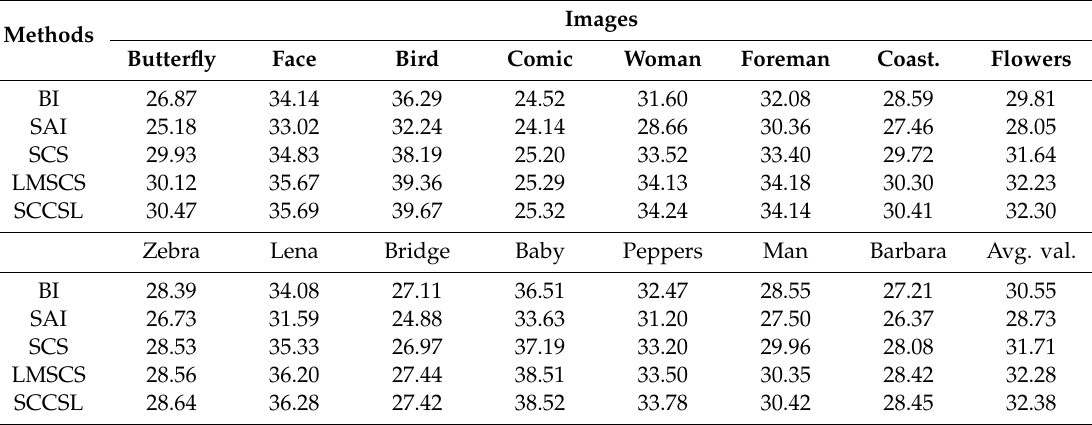
Table 1. The PSNR (dB) results of the 15 images by di ff erent methods, and bold font indicates that the algorithm has the best PSNR value on a single image.